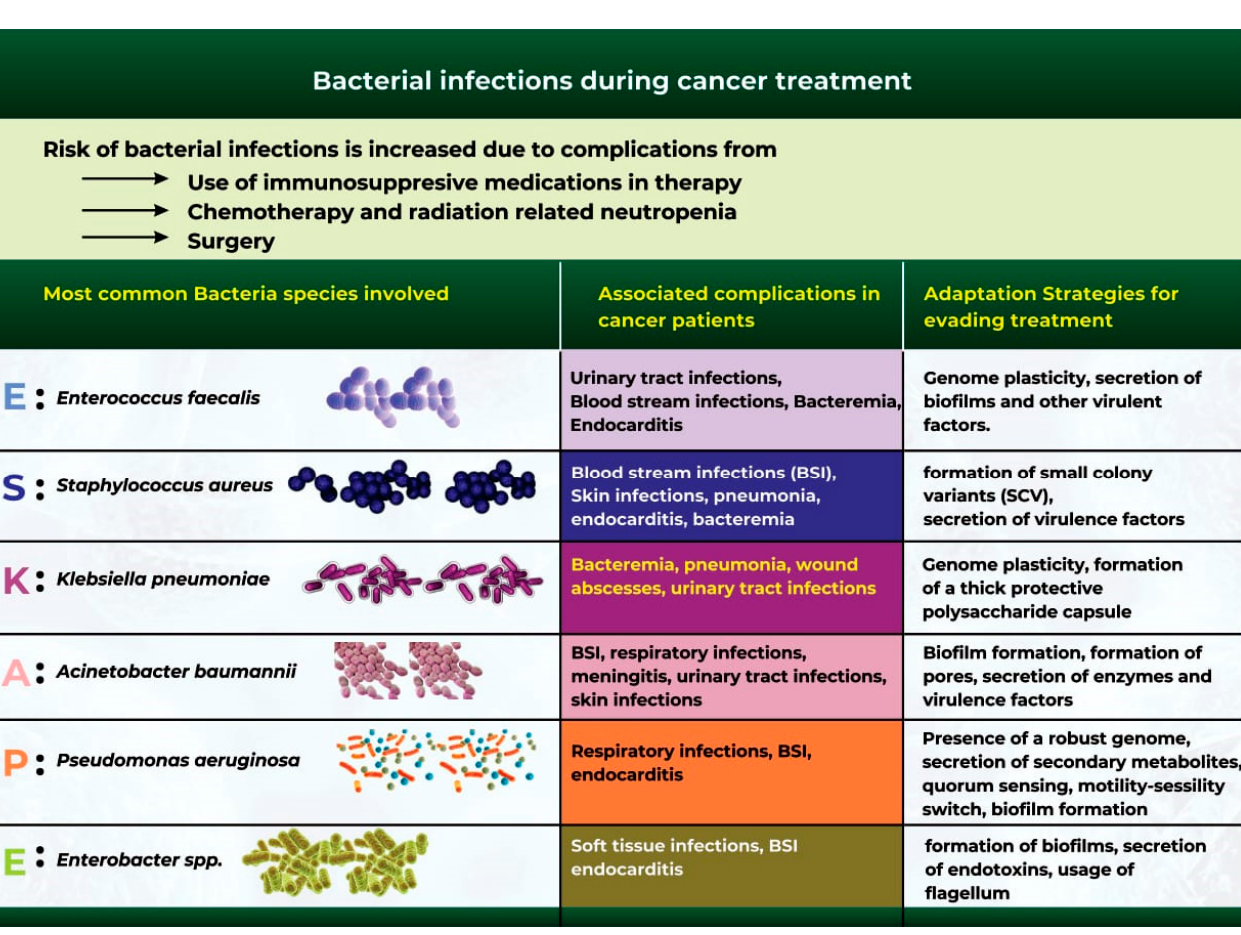
Figure 3. The most common bacterial species that cause bacterial infections during cancer therapy .